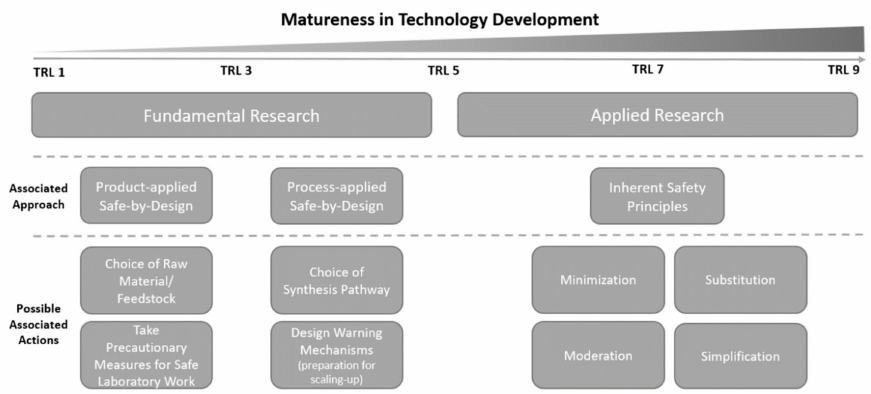
Figure 2. Defined Technology Readiness Levels with the associated type of research, approach (Safe-by-Design (SbD) or the Inherent Safety Principles (ISPs)) and possible safety measures to